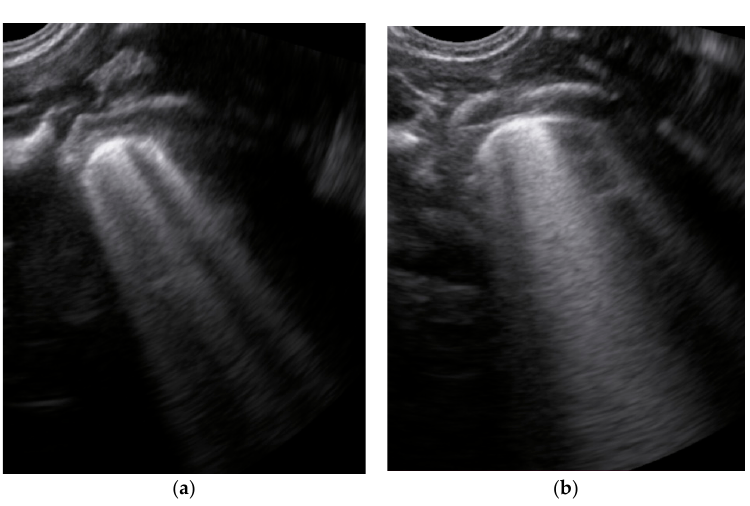
Figure 3. The lung ultrasound showed ( a ) sparse B-lines with small zones of pleural irregularities corresponding to a LUSS = 1; ( b ) confluent B-lines with aspect of ‘white-lung ‘corresponding to LUSS = 2.